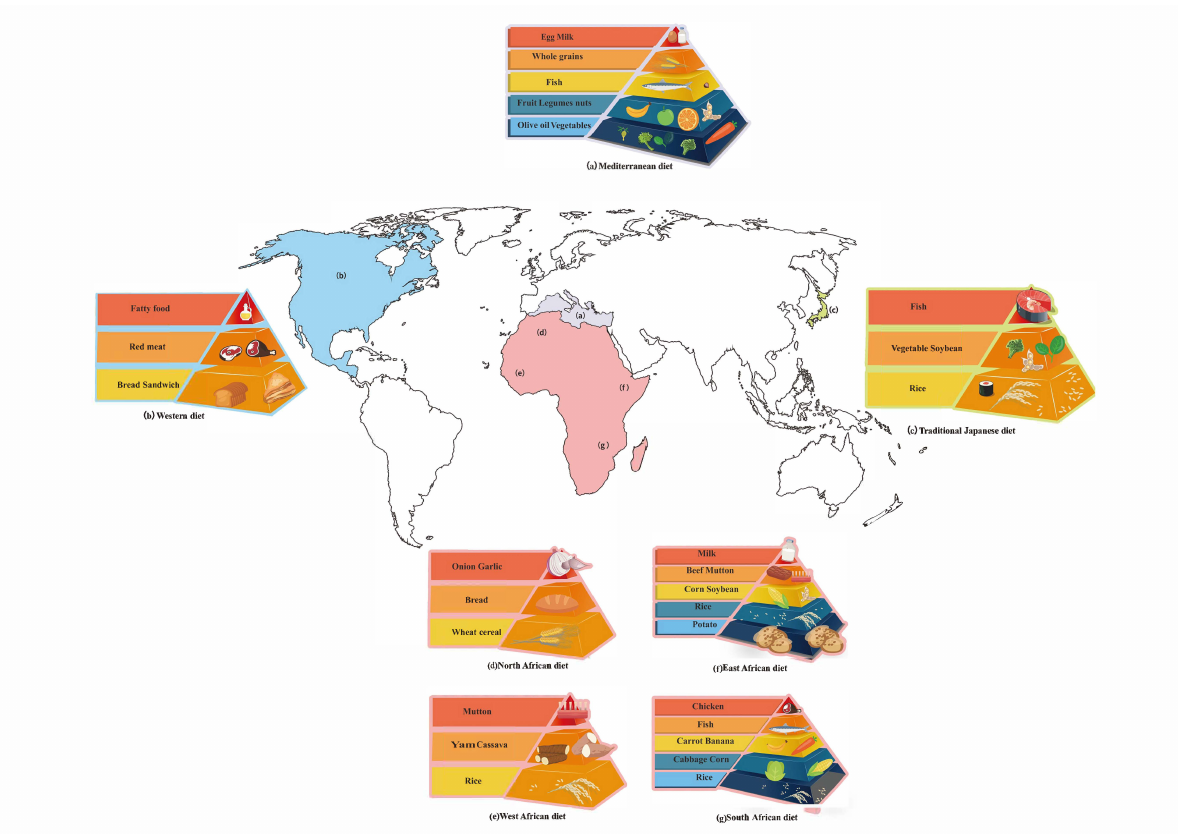
Figure 2. This figure illustrates the food habits in several representative areas of the world. ( a ) The most distinctive feature of the Mediterranean diet is that most people use olive oil as a source of fat. The diet is based on plant foods like carrots, bananas and oranges, with a small amount of fish, whole grains, milk, and eggs. ( b ) However, Westerners eat bread and sandwiches as staple food, and they prefer cheese. ( c ) Grains and rice are staples of the traditional Japanese diet. Vegetables and peas are often eaten in Japan. Because of developed fisheries, fish is common in the Japanese diet. ( d ) African diets are diverse and complex, with di ff erent regions having di ff erent eating habits and cultures. In North Africa, they eat grains and bread as staple foods, and onions and garlic are the most common vegetable. ( e ) Nonetheless, rice is a staple food of western Africans and cassava and sweet potatoes are the most unique elements of their diet [157]. ( f ) In East Africa, potatoes and rice are their staple food and corn and peas are also popular with the locals. Their main meat is beef and mutton and they also drink milk as a nutritional supplement. ( g ) Rice is the staple food in South Africa and cabbage, corn and carrots are quite popular there. South Africa is rich in bananas, so bananas are a common fruit. The main meats are fish and chicken because of geographical environment factors. In a nutshell, because of di ff erences in religion and eating habits, each region has its own unique style of